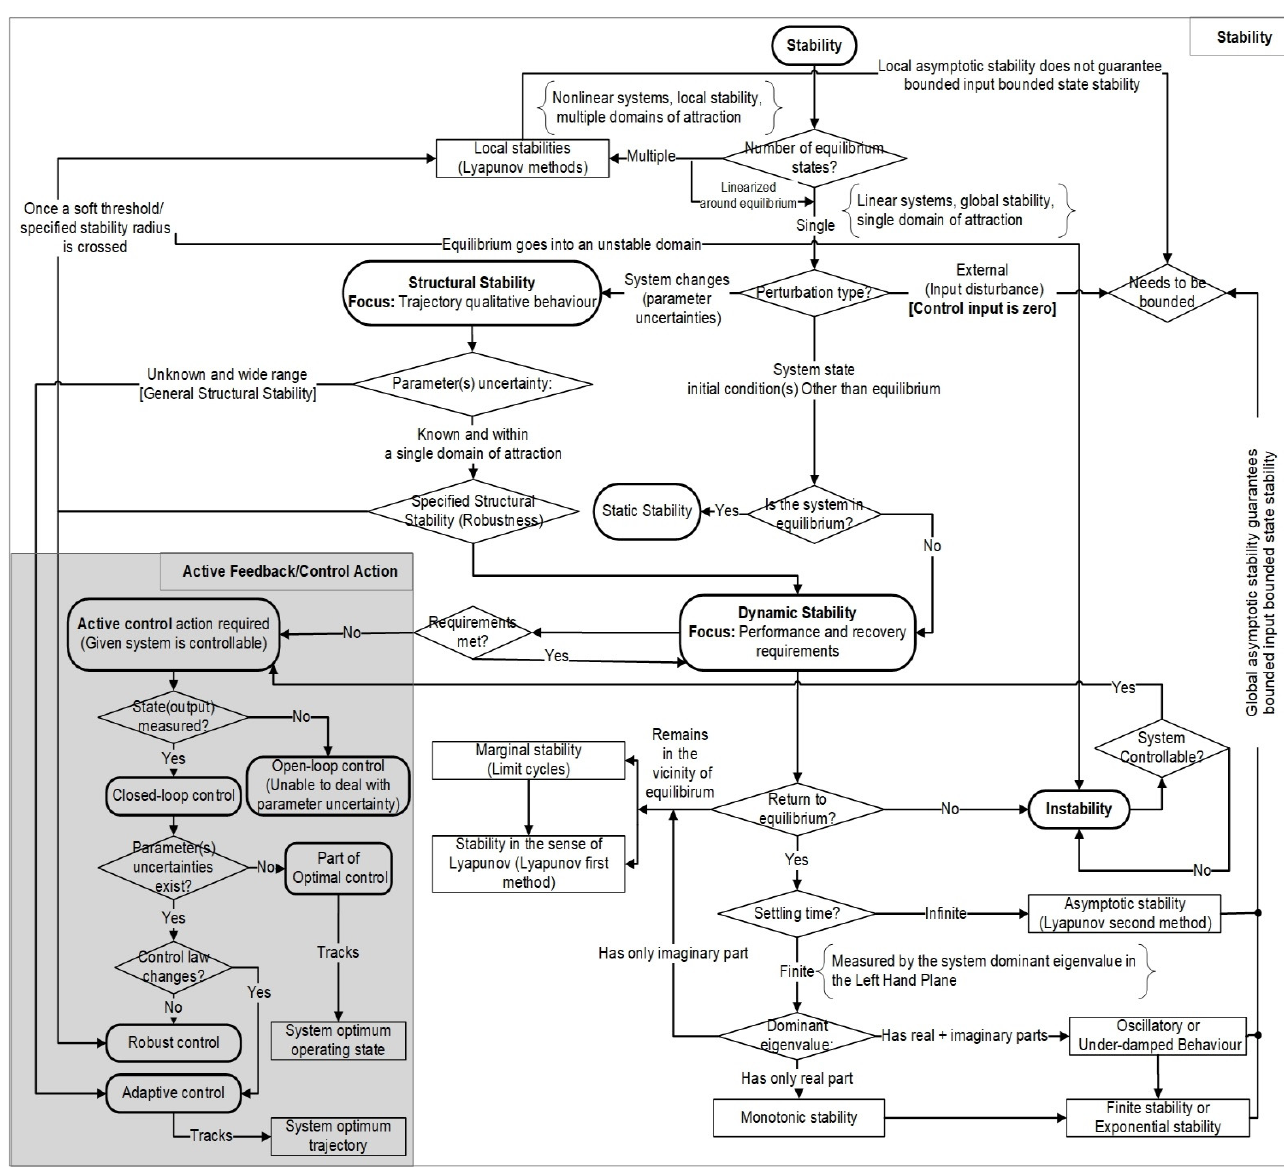
Figure 6. Linkages between dynamic stability, structural stability, and active control action—a unified and big picture.